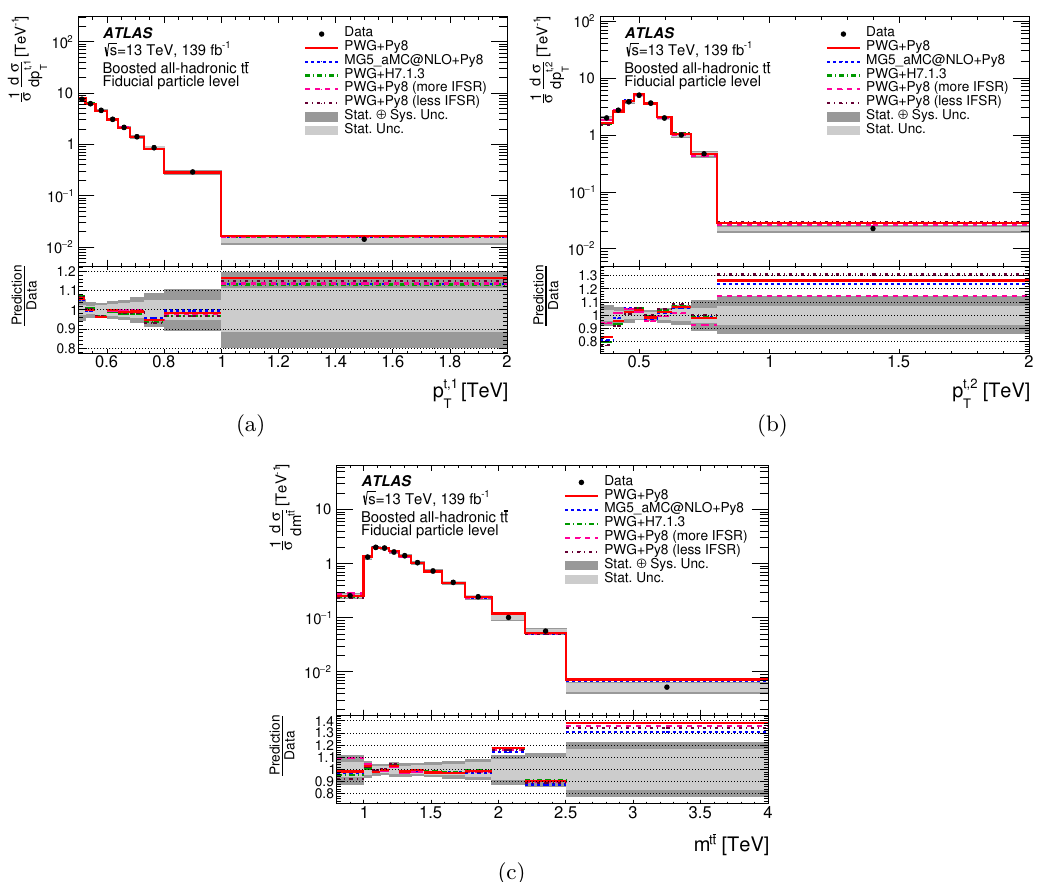
Figure 10 . Normalized particle-level fiducial phase-space differential cross-sections as a function of (a) the p T of the leading top-quark jet, (b) the p T of the second-leading top-quark jet, and (c) the invariant mass of the t ¯ t system. The dark and light grey bands indicate the total uncertainty and the statistical uncertainty, respectively, of the data in each bin. Data points are placed at the centre of each bin. The Powheg+Pythia 8 MC sample is used as the nominal prediction to correct the data to particle